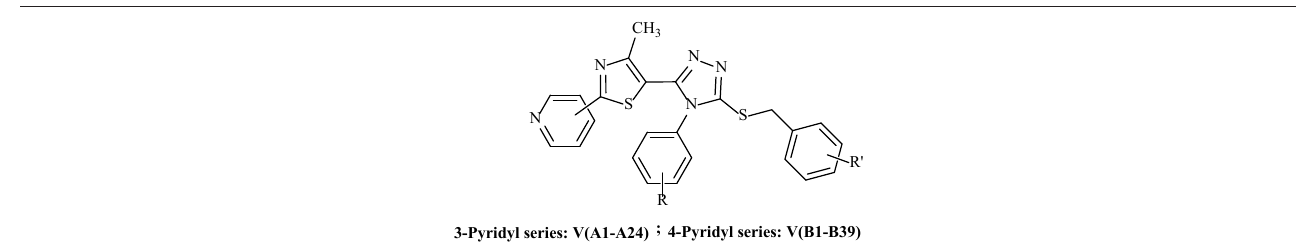
TABLE I - S tructures of the synthesized compound series V (A1-A24, B1-B39)